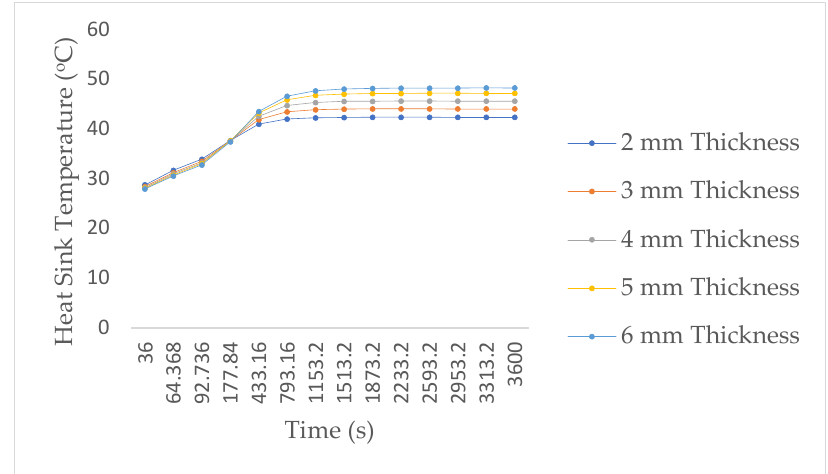
Figure 5. Temperature plot of heat sink at 9.7 W.